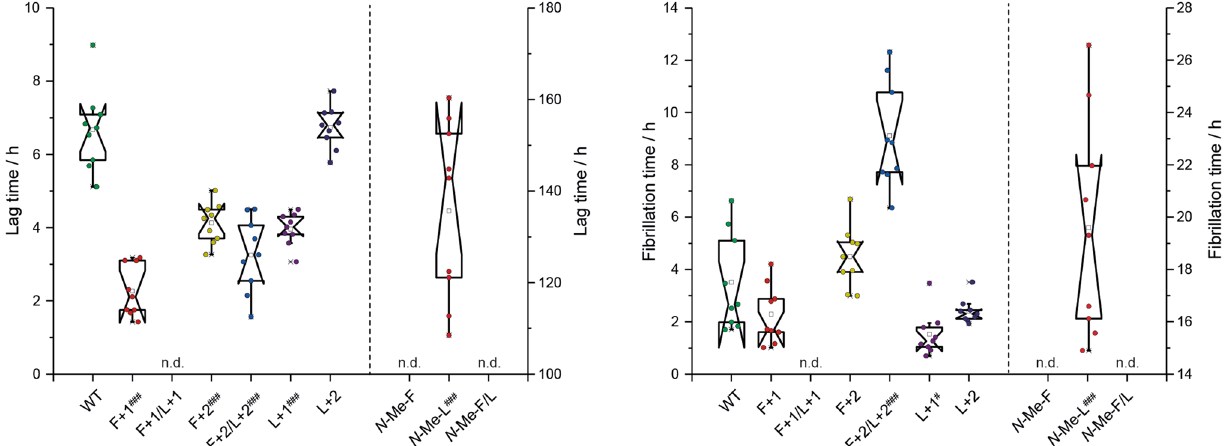
Figure 3. Box plot representation of the two characteristic parameters lag time (left) and fibrillation time (right) determined from ThT fluorescence fibrillation kinetics experiments. The peptide variants N -Me-F and N -Me-F/L do not fibrillate, while data for F+1/L+1 could not be fitted with the applied function (n.d. means not determined). Data from three independent experiments with three replicates each are shown. Peptide concentration was 0.125 mg mL −1 in an aqueous 25 mM sodium phosphate buffered solution (pH 7.4) containing 150 mM NaCl and 0.01%(w/v) NaN 3 . All normalized fluorescence intensity vs. time plots are given in the supporting information (supplementary Fig. S1). Significance was tested applying a heteroscedastic Student’s t-Test using two-tailed distributions, # p ≤ 0.05; ## p ≤ 0.01; ### p ≤ 0.001 vs WT